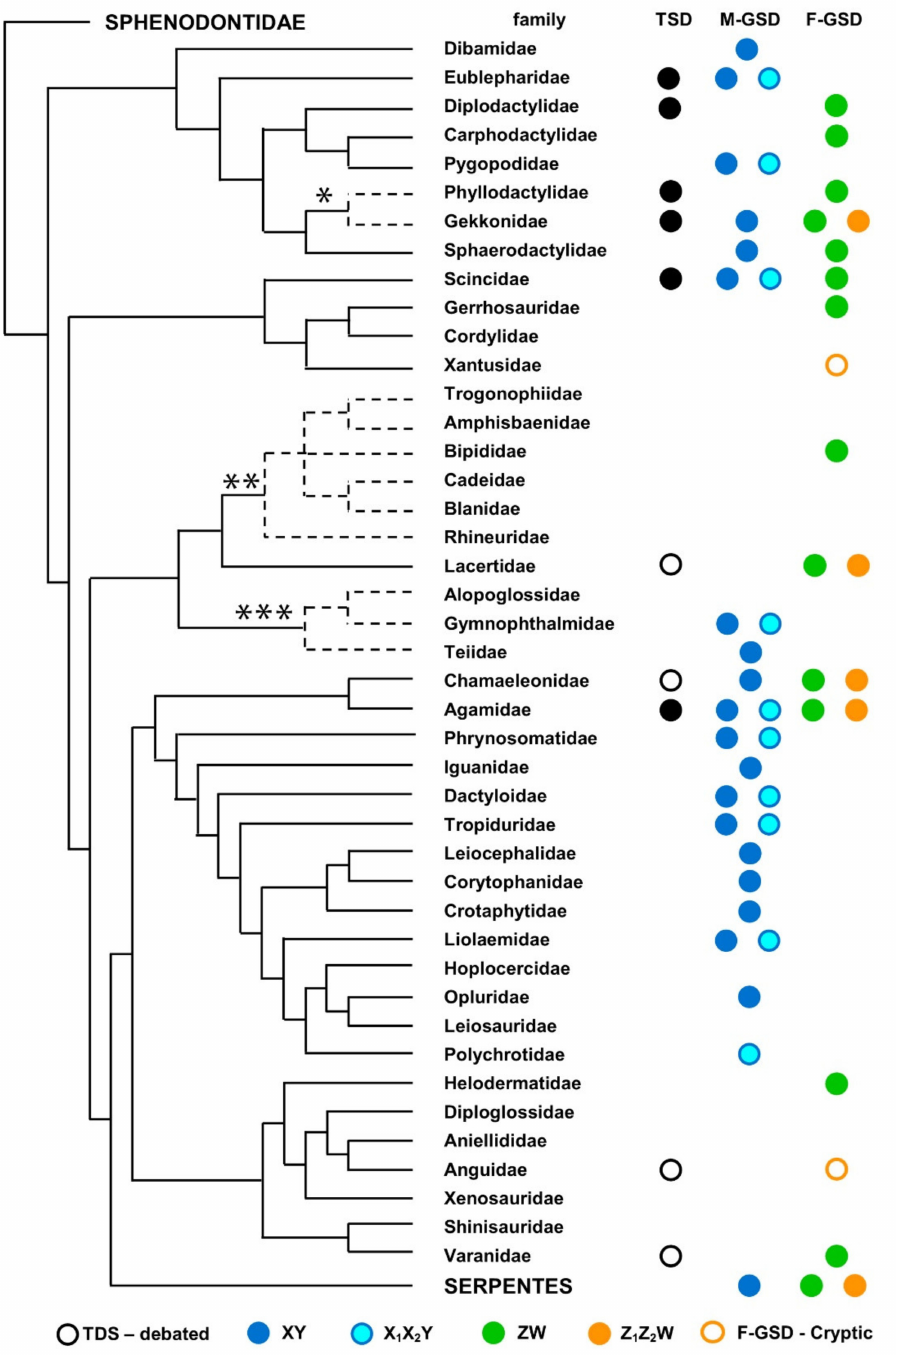
Figure 2. Distribution of TSD and male (M-GSD) and female (F-GSD) genetic sex determination on lizard phylogenetic relationships redrawn from Reference [21]. Dashed lines represent phylogenetic relationships by * Reference [18], ** Refer- ence [19] and *** Reference